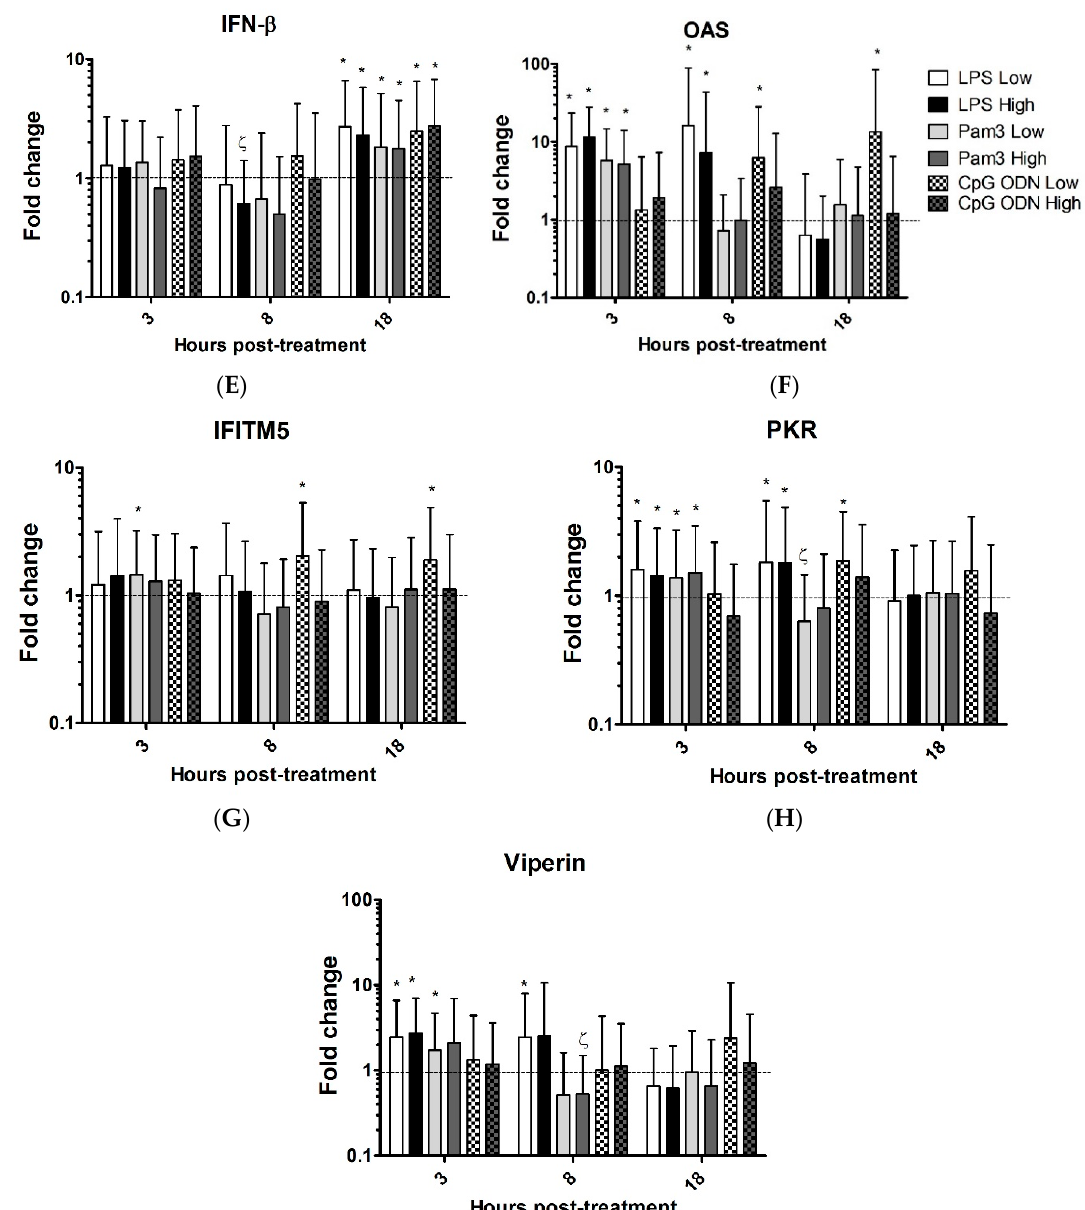
Figure 1. Relative expression of candidate genes interleukin 1 beta (IL ‐ 1 β ) ( A ); inducible nitric oxide synthase (iNOS) ( B ); interfon (IFN) regulatory factor 7 (IRF7) ( C ); IFN ‐α ( D ); IFN ‐β ( E ); oligoadenylate synthetase (OAS) ( F ); IFN induced transmembrane protein 5 (IFITM5) ( G ); protein kinase R (PKR) ( H ); Viperin (I), in the chicken trachea. Tracheal organ cultures (TOCs) were treated with two different concentrations of lipopolysaccharide (LPS) from Escherichia coli ( E. coli ) O26:B6 (1.0 μ g/mL (LPS low) and 10 μ g/mL (LPS high)), Pam3CSK4 (1.0 μ g/mL (Pam3 low) and 10 μ g/mL (Pam3 high)), CpG ODN 1826 (1.0 μ g/mL (CpG ODN low) and 10 μ g/mL (CpG ODN high)). Control groups received either non CpG ODN (10 μ g/mL) or medium. Gene expression was assessed at 3, 8 and 18 h post ‐ treatment using quantitative real ‐ time (RT) ‐ PCR, relative to the housekeeping gene β‐ actin. Gene expression is presented as fold change relative to the medium group in LPS and Pam3CSK4 (low and high doses) groups. Gene expression is presented as fold change relative to the non CpG ODN group in CpG (low and high doses) groups. Error bars represent standard errors of the means. Fold changes and standard errors were calculated using REST software. Significant up ‐ regulation ( p ≤ 0.05) is indicated by *. Significant down ‐ regulation is indicated by ζ . There were six biological replicates in each group.